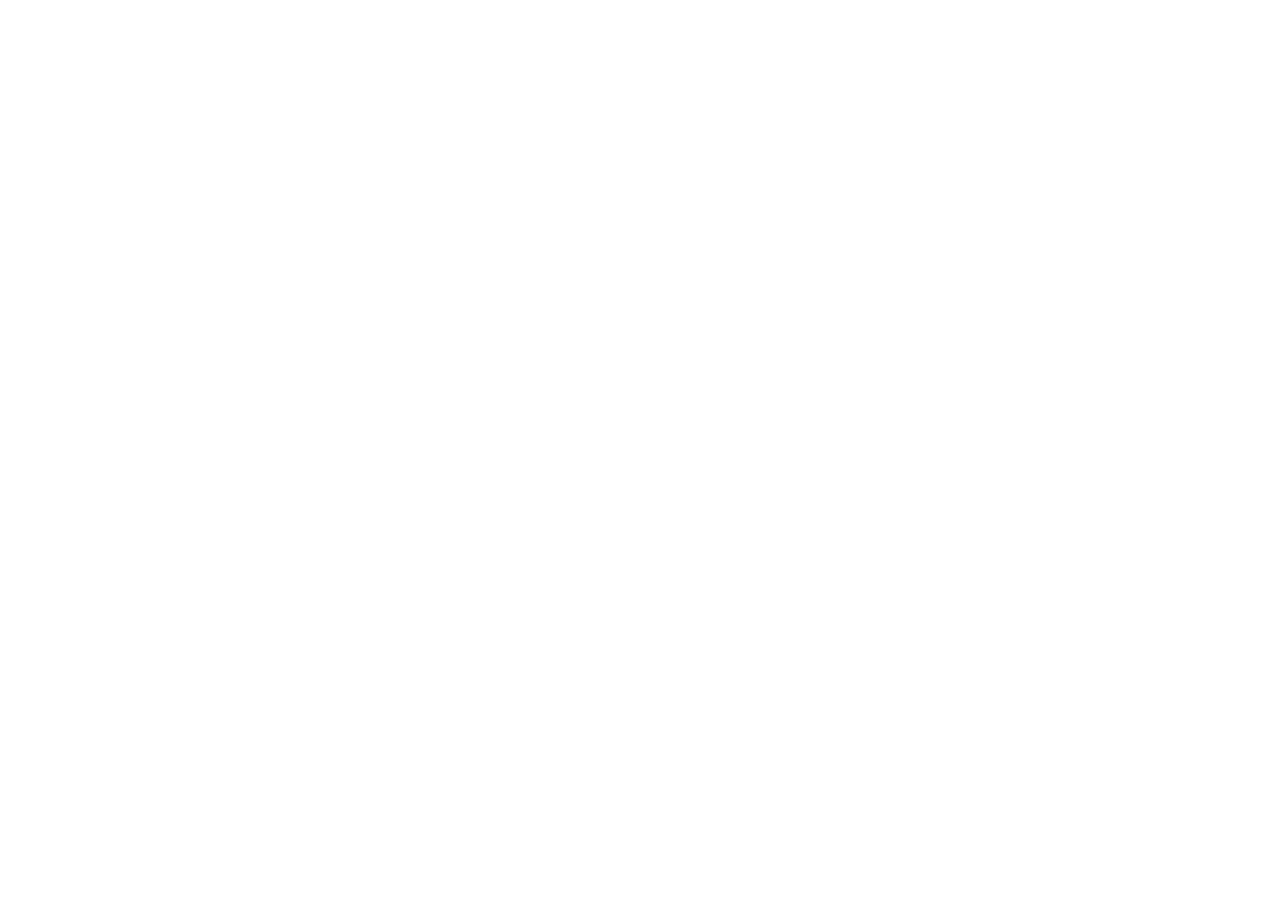
Frontiers in Molecular Biosciences |